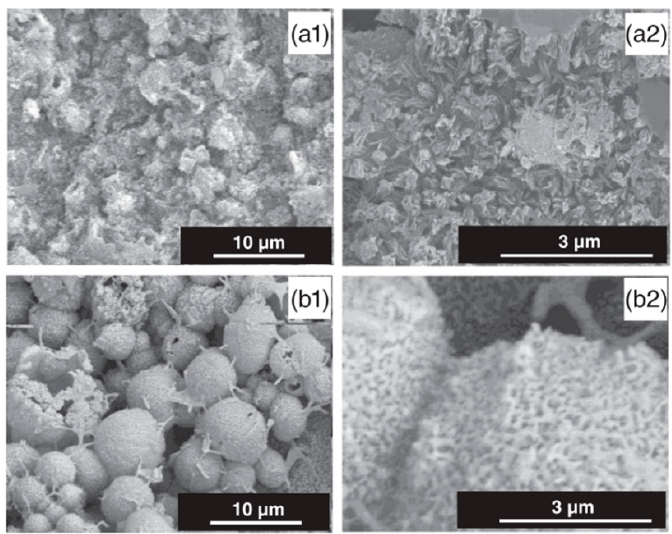
Figure 16. SEM images of coatings prepared from two electrolytes on the oxidation-iron foam substrates using EPD and then immersed into PBS for different days. ( a ) K-II coatings prepared from 40% nHA / ethanol suspension mixed with 60% nHA / chitosan–acetic acid aqueous solution (E-II electrolyte) and then immersed into PBS for 10 days; ( b ) K-III coatings prepared from 100% nHA / chitosan–acetic acid aqueous solution (E-III electrolyte) and then immersed into PBS for 15 days; ( a1 , b1 ) magnification of 3000; ( a2 , b2 ) magnification of 15,000. Reprinted from Reference [6] with permission from Elsevier.